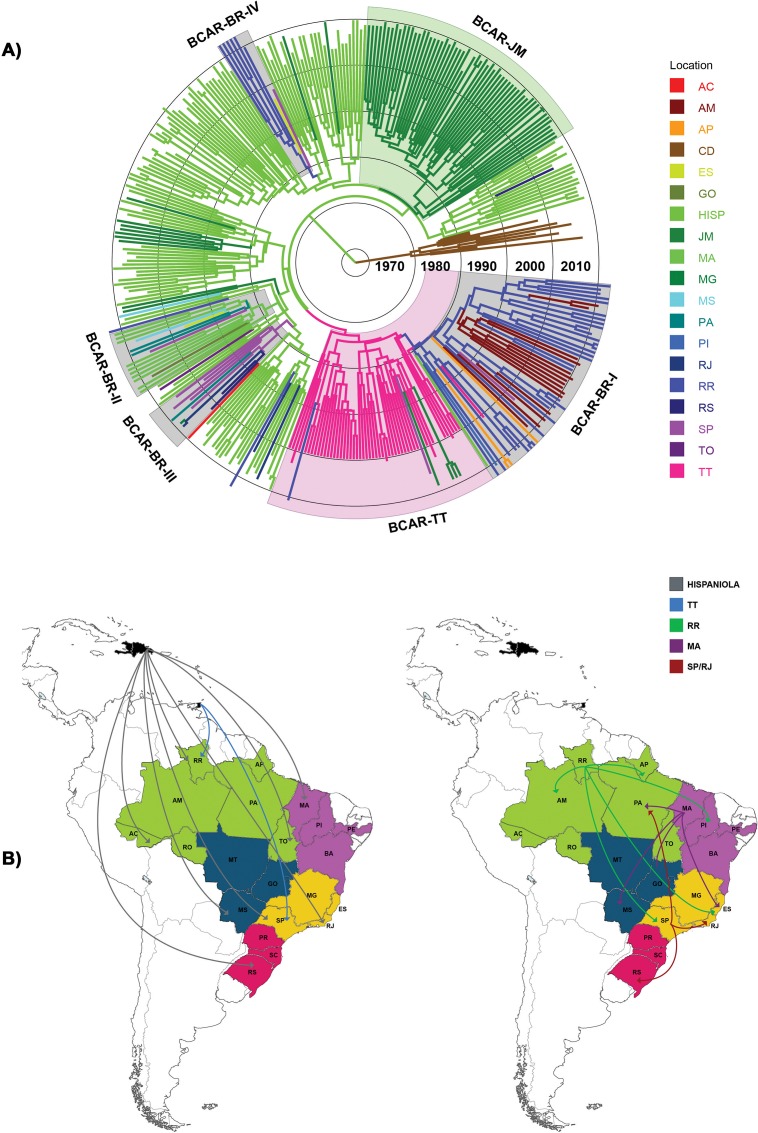
Spatiotemporal dynamics of dissemination of HIV-1 BCAR clades circulating in the Caribbean and Brazil.A) Time-scaled Bayesian MCMC tree of pol PR/RT sequences of HIV-1 BCAR lineages from Brazil (n = 97) and the Caribbean (n = 258), and subtype D reference sequences (n = 10) from the Democratic Republic of Congo. Branches are colored according to the most probable location state of their descendent nodes as indicated in the legend at right. Colored boxes indicate the positions of major BCAR clades detected in Brazil, Jamaica and Trinidad and Tobago. Branch lengths are depicted in units of time (years). The tree was automatically rooted under the assumption of a relaxed molecular clock. B) Lines between locations represent branches in the Bayesian MCC tree along which location transitions occurred and were colored according to the location of origin (see the legend at left). Maps were created from templates obtained from d-maps.com (Caribbean: http://d-maps.com/carte.php?numcar=1389&lang=en; South America: http://d-maps.com/carte.php?numcar=2313&lang=en; and Brazil: http://d-maps.com/carte.php?numcar=4843&lang=en). AC: Acre; AM: Amazonas; AP: Amapá; CD: Democratic Republic of Congo; ES: Espírito Santo; GO: Goiás; HISP: Hispaniola; JM: Jamaica; MA: Maranhão; MG: Minas Gerais; MS: Mato Grosso do Sul; PA: Pará; PI: Piauí; RJ: Rio de Janeiro; RR: Roraima; RS: Rio Grande do Sul; SP: Sao Paulo; TO: Tocantins; TT: Trinidad and Tobago.